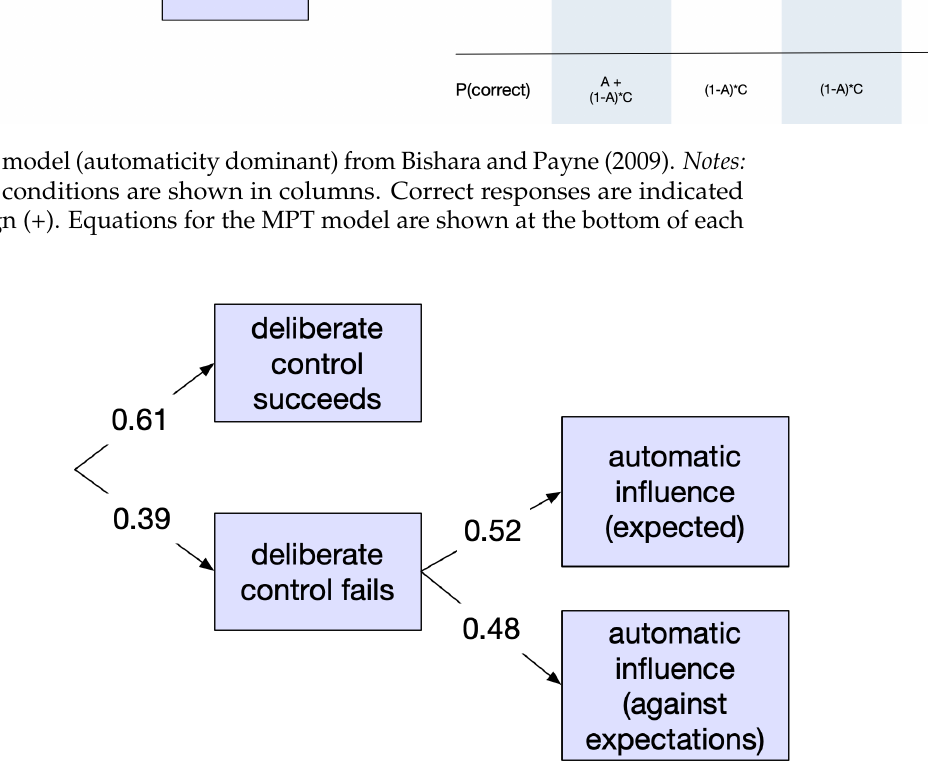
Figure 3: Estimated probabilities from process dissociation model from Bishara and Payne (2009). Notes: Values are averages for the C and A parameters presented in Bishara and Payne’s (2009) Appendix C for the Lambert et al. (2005)